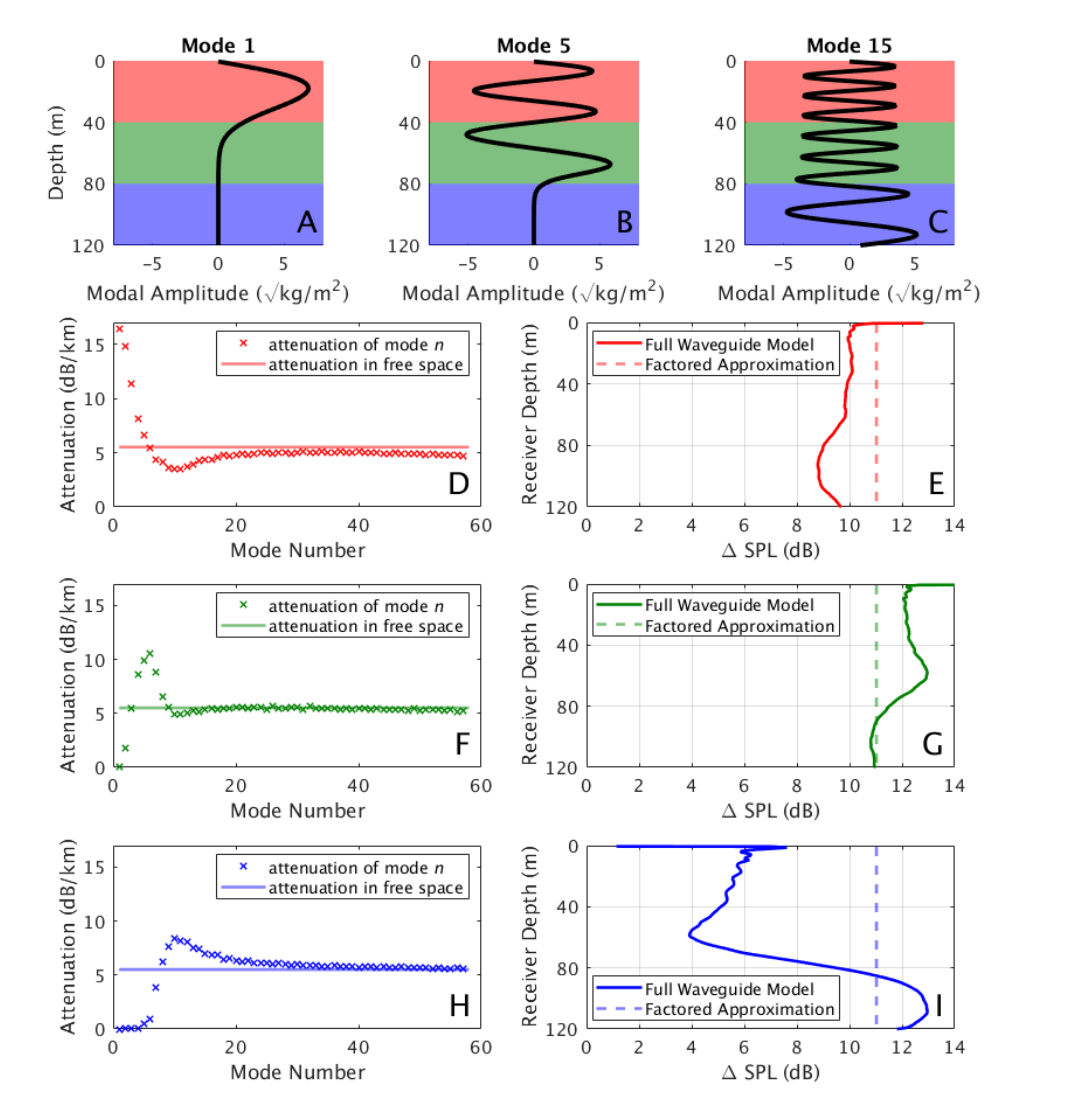
Figure 3. When an occluding fish shoal is concentrated at a specific water depth, attenuation will be complicated by waveguide effects so that the free-space-like factored approximation of Equation (14) may not be valid. Here, attenuation during one-way propagation is modeled for Ålesund herring shoals uniformly distributed between depths 0–40 m (red), 40–80 m (green) and 80–120 m (blue). Attenuation coefficients associated with given modes and their coupling depends on the specific modal contributions at the depths where the fish group is present ( A – C ). Since the environment modeled here is upward refracting, the lowest order modes are most attenuated when the herring occupy the upper water column ( D ) but they are essentially unattenuated when the herring occupy the lower water column ( H ). In the case where herring are concentrated near the seafloor, a receiver in the upper water column will receive a strong signal from unattenuated lower order modes, causing the free-space-like factored approximation to overestimate the total attenuation ( ∆ SPL ) by more than 5 dB ( I ). If the herring are concentrated near the sea surface ( D , E ) or near the center of the water column ( F , G ), the free-space-like factored approximation is seen to be in error by on the order of 2 dB. Herring are modeled here with expected scatter function (cid:104) S (cid:105) = − 0.03 + 0.10 i in a shoal with width 2 km and areal population density 2.5 fish/m 2 estimated from echosounding data, with seafloor depth at 120 m, source depth at 60 m with frequency 955 Hz and Ålesund sound speed profiles shown in Appendix F. Water density is modeled as 1000 kg/m 2 , seafloor density as 1900 kg/m 2 and seafloor sound speed as 1700